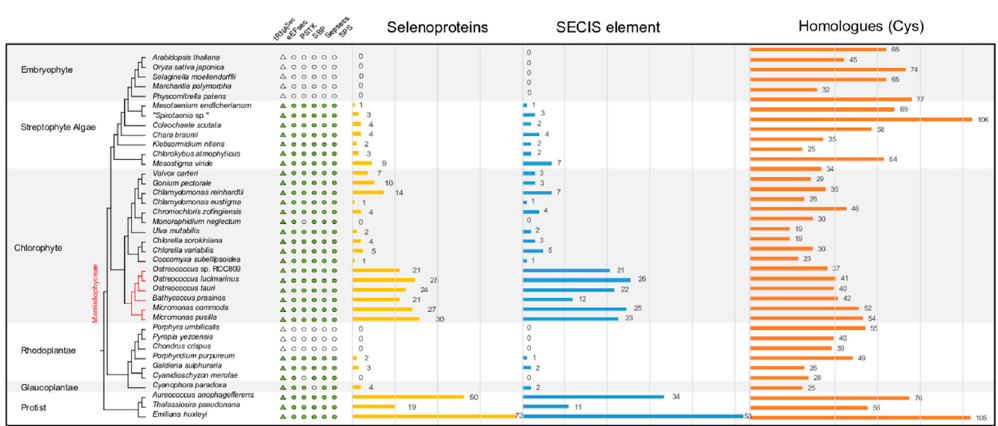
Figure 1. The number and distribution of selenoproteins, and enzymes involved in the Sec machinery. The phylogenetic tree was retrieved from the National Center for Biotechnology Information (NCBI) taxonomy database and the 1,000 Plants (1KP) Project (http://www.onekp.com). Presence (green symbols) or absence (empty symbols) of the enzymes involved in the Sec machinery (circles) and tRNA Sec (triangles) across sequenced embryophyte, streptophyte algae, chlorophyte, Rhodoplantae, Glaucoplantae and protist genomes are shown in the left panel. The distribution and number of selenoproteins are plotted in the yellow column in the second panel, and the predicted (Selenocysteine Insertion Sequence) SECIS elements are represented by the blue bars. Distribution and number of selenoprotein homologues (Cys) are plotted in an orange column on the right panel. Prasinophyte algae (Mamiellophyceae) are highlighted in red.